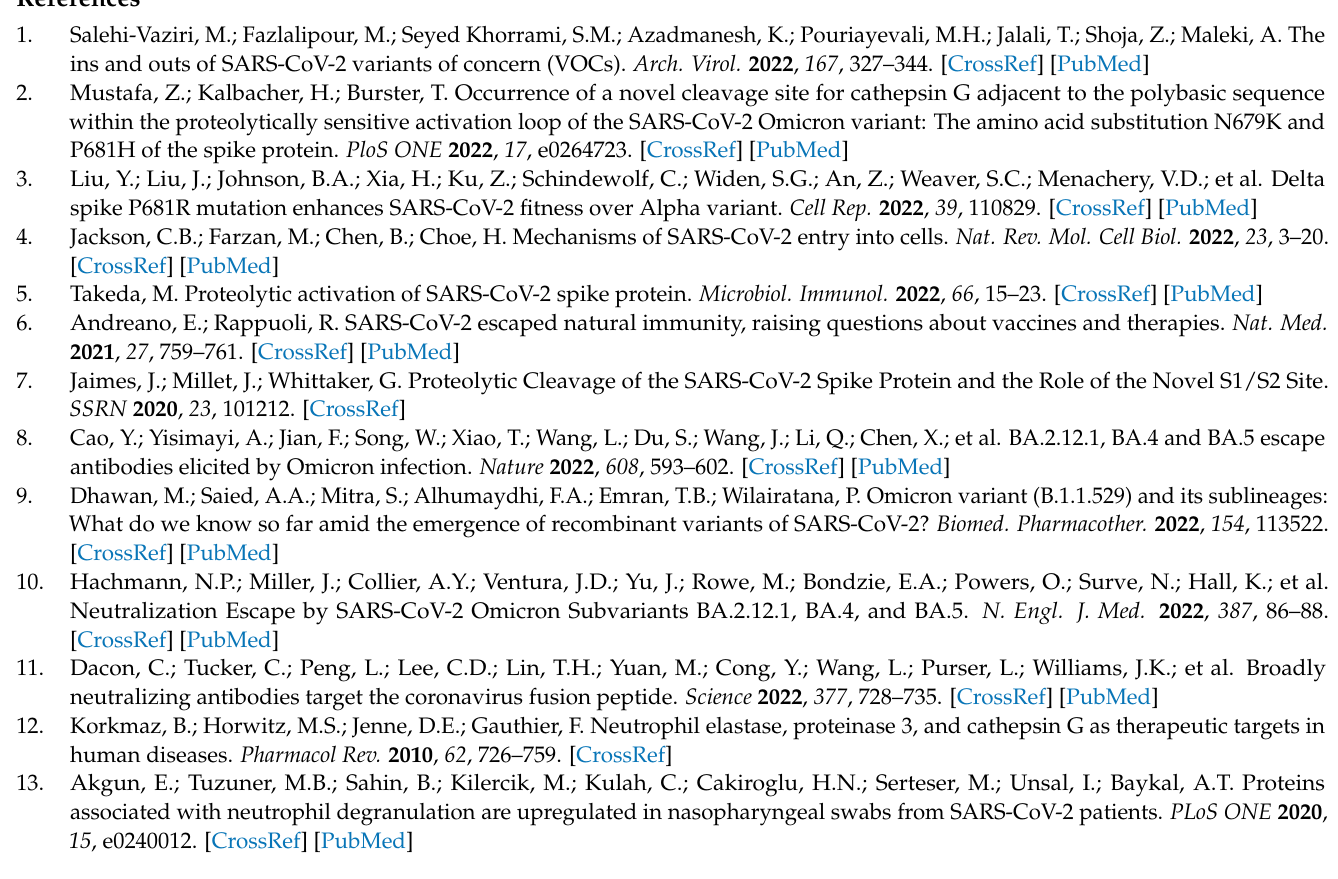
Figure S7: Peptide digest with CatG, high-resolution MS/MS spectra from peptides.; Figure S8: Peptide digest with PR3, high-resolution MS/MS spectra from